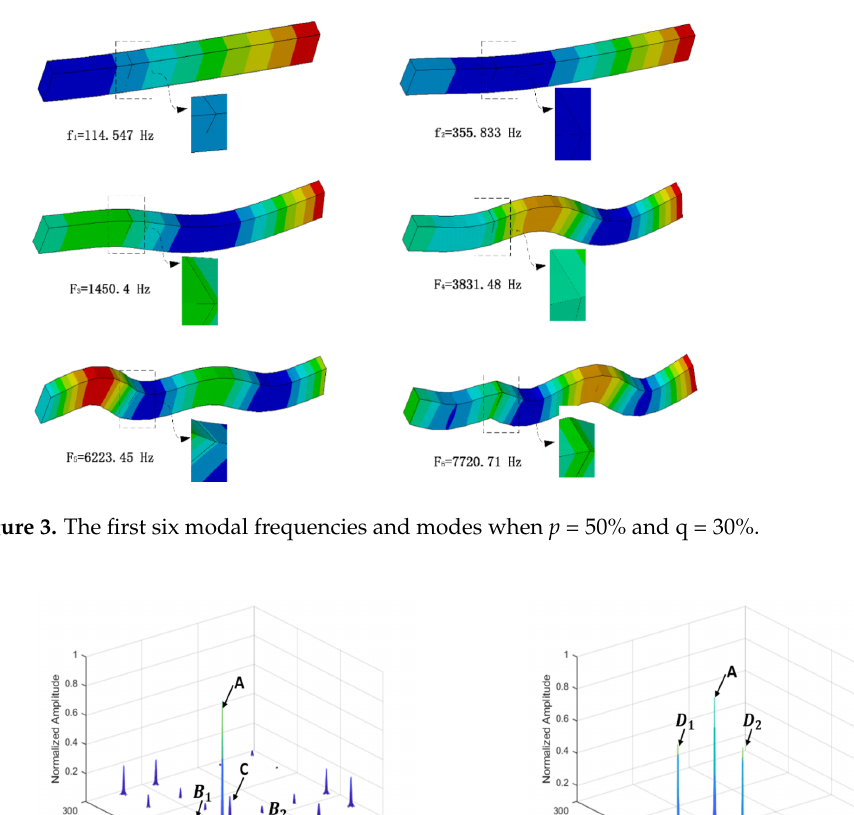
Figure 3. The first six modal frequencies and modes when p = 50% and q = 30%.